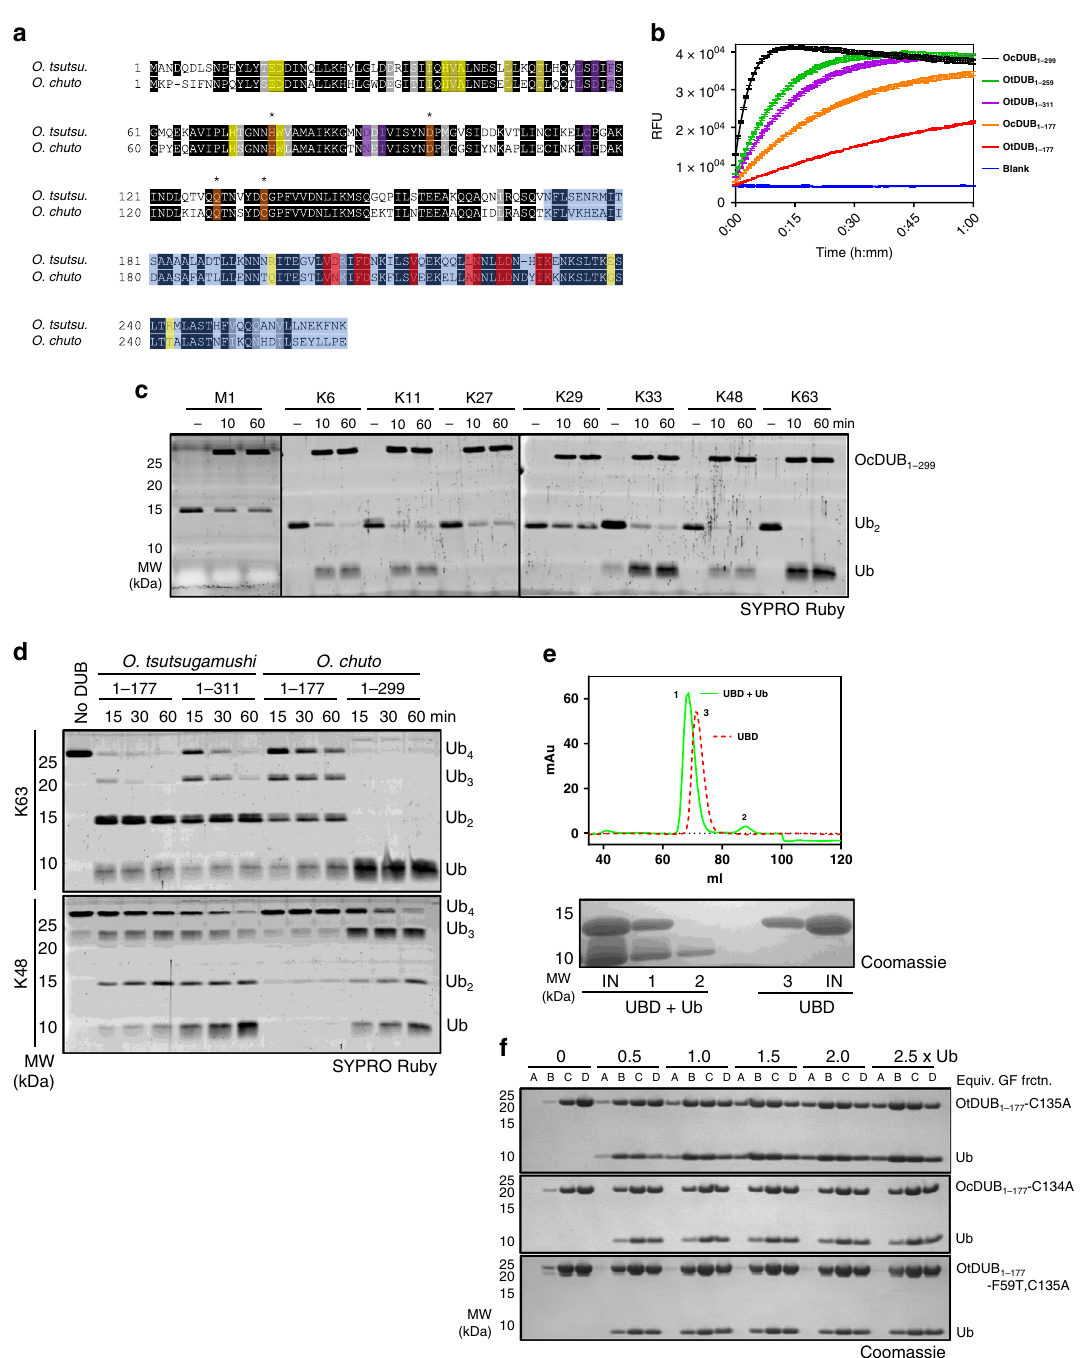
Fig. 7 OtDUB activities are conserved in Orientia chuto . a Amino acid alignment of the DUB/VR-1 region of OtDUB and its homolog in Orientia chuto . Identical and similar amino acids are boxed in black and gray, respectively, and the conserved catalytic triad and oxyanion hole residues are boxed in orange and starred. UBD boundaries are boxed in light blue. The ubiquitin-interacting residues are boxed for the S1 site (yellow), S2 site (purple) and the UBD (red). b Ub-AMC-cleavage assays comparing OtDUB and OcDUB activities. Ub-AMC (400 nM) was incubated alone (Blank) or with OtDUB 1 – 177 , OtDUB 1 – 259 , OtDUB 1 – 311 , OcDUB 1 – 177 , or OcDUB 1 – 299 (350 pM). Lines represent the means of technical triplicates with SD bars at each 40-s interval. c Representative results for an in vitro cleavage assay using di-ubiquitin substrates (1 µ M each) that were incubated in the presence or absence of OcDUB 1 – 299 (0.5 µ M) for the indicated times and resolved by SDS-PAGE ( n = 2). Black lines denote separate gels. Source data are provided as a Source Data fi le. d In vitro cleavage of tetra-ubiquitin chains (2 µ M) by OtDUB 1 – 177 , OtDUB 1 – 311 , OcDUB 1 – 177 , or OcDUB 1 – 299 (50 nM) ( n = 2). Source data are provided as a Source Data fi le. e SEC peak shift assay for O. chuto UBD 170 – 299 -ubiquitin association (top). Orientia chuto UBD 170 – 299 of 2.5 mg were run on a Superdex 75 column alone (red), or mixed with equimolar amounts of ubiquitin (green), n = 2. Inputs and peak fractions were resolved by SDS-PAGE (bottom). Source data are provided as a Source Data fi le. f Ubiquitin-binding titration experiment for ubiquitin binding at the putative OcDUB S2 site. OtDUB 1 – 177 -C135A, OcDUB 1 – 177 -C134A, and OtDUB 1 – 177 -F59T,C135A (1 mg, 250 μ M) preincubated with the indicated molar ratio of ubiquitin were run on a Superdex 75 FPLC column. Equivalent fractions of each run (A, B, C, D) were resolved by SDS-PAGE. Source data are provided as a Source Data fi